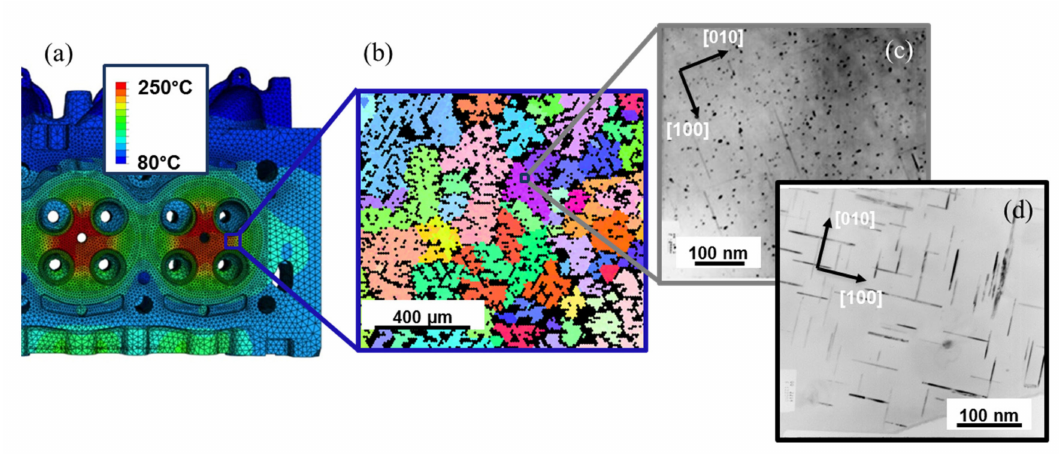
Figure 2. ( a ) Temperature map on the cylinder head fire deck. ( b ) Electron Backscatter Di ff raction (EBSD) Inverse pole figure showing the grain microstructure in the inter-valve bridge. ( c ) Alloy AlSiCu0.5Mg0.3 T7, initial hardening precipitates microstructure, ( d ) AlSi7Cu3.5Mg0.1 T7, initial hardening precipitates microstructure.